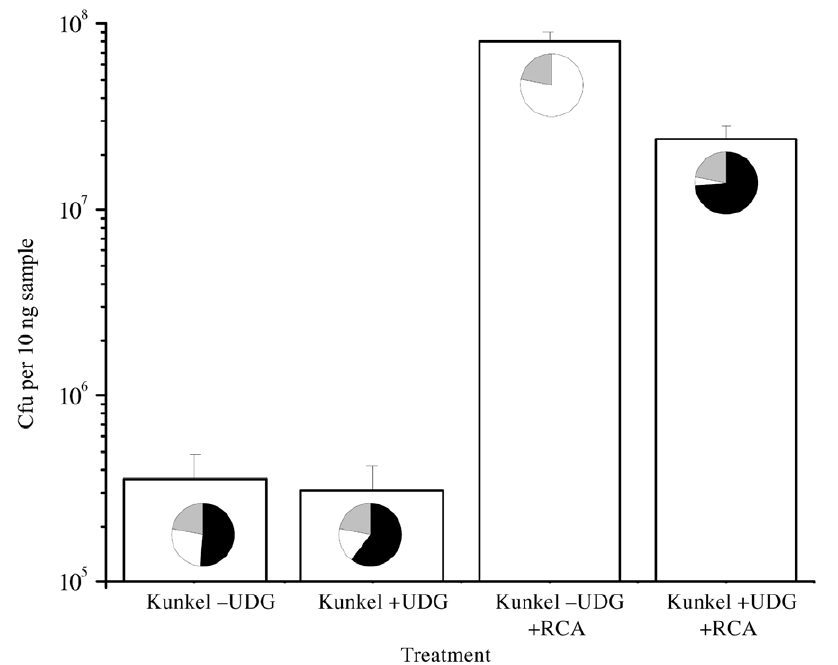
Figure 3. The effect of UDG treatment on Kunkel and selective rolling circle amplification (RCA) mutagenesis. CDR-H3 region was altered by Kunkel mutagenesis and further treated with + / 2 UDG and amplified with RCA. The mutant yield was studied by plating transformed samples. Successful CDR-H3 primer incorporation in scFv- b -lactamase gene resulted in ampicillin resistant clones (pie chart, black sector). The template clones were sensitive to ampicillin (pie chart, white sector). In theory, 22% of the mutated clones with 7 6 NNN codons are not ampicillin resistant due to primer-born STOP-codons (pie chart, grey sector).